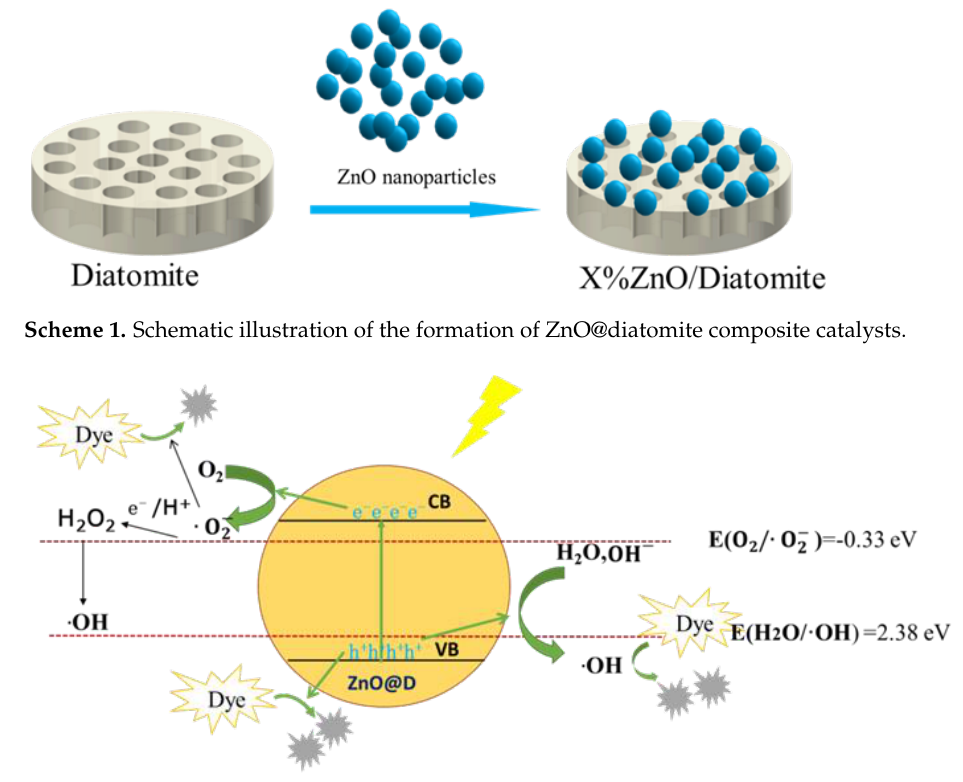
Figure 9. Schematic drawing of photocatalytic mechanism of ZnO@diatomite.